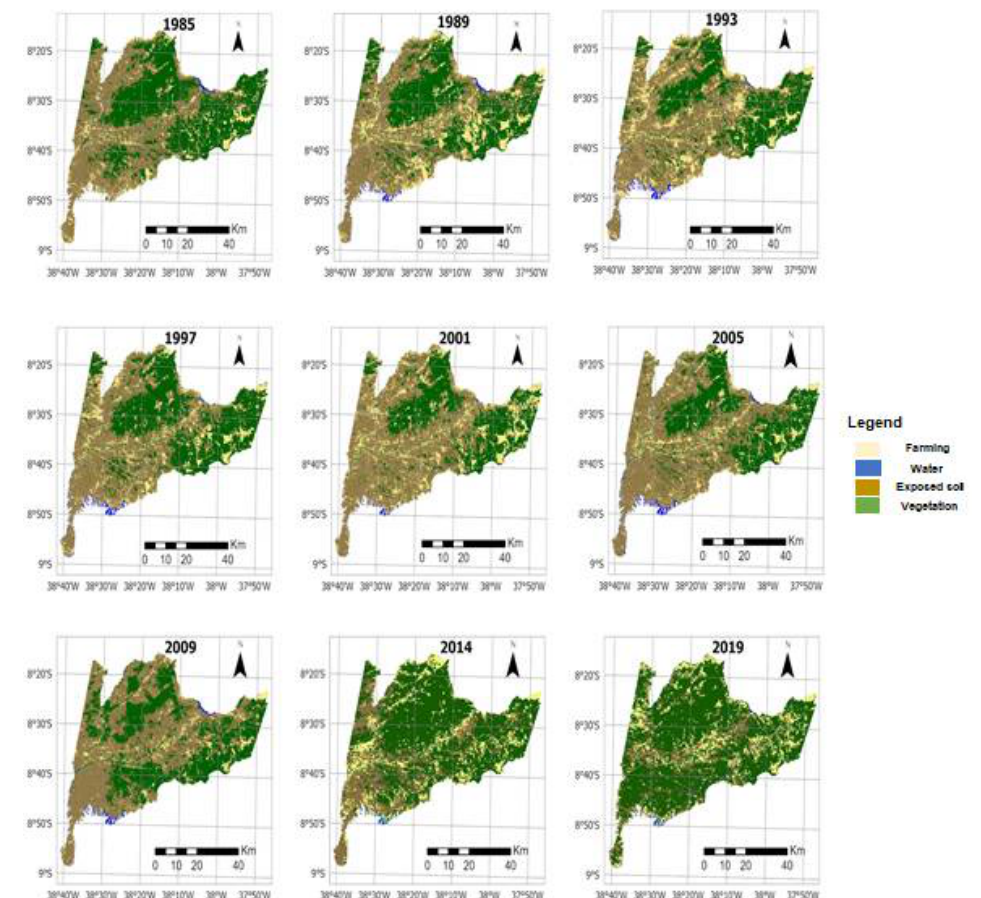
Figure 2. Thematic maps of land use in the municipality of Floresta-PE from 1985 to 2019.